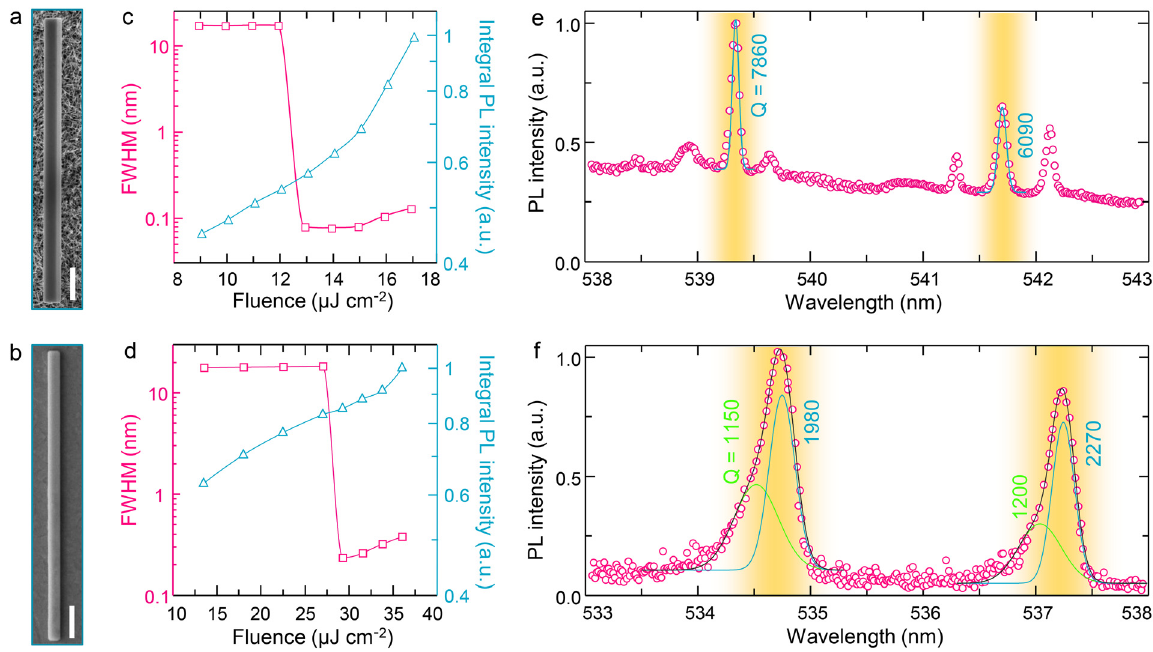
Figure2: (a,b)SEMimagesofNW 1 onNSITOandNW 2 on fl atITO,respectively(scalebarsare1 μ m).(c,d)PLintensityandFWHMvalueversus excitation fl uence for the nanowires. The laser threshold for NW 1 (c) is two times lower than that of NW 2 (d). (e, f) Q las -factor analysis of the stimulated emission spectra observed for the NWs at the threshold fl uence. For fi tting the laser peaks, a Gaussian function is employed. NW